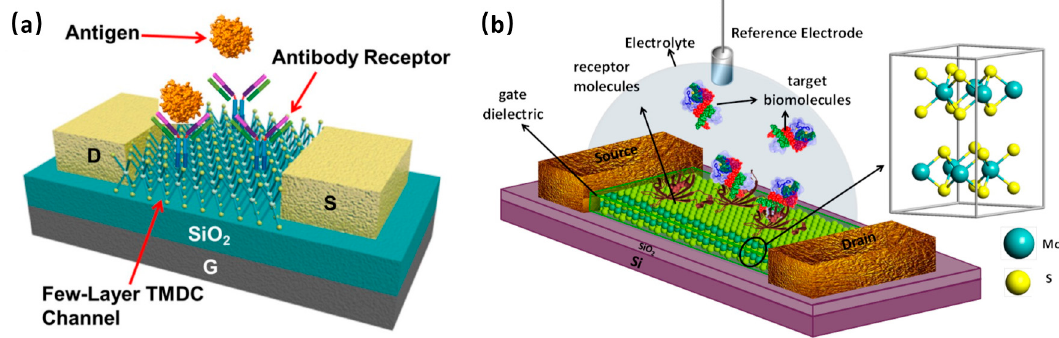
Figure 1. ( a ) Schematic illustration of the back-gated field-effect transistors (FET) biosensor with a few-layer transition metal dichalcogenide (TMDC) sensing channel [33]. Reprinted with permission from ref [33]. Copyright 2015 American Vacuum Society. ( b ) Schematic diagram of liquid-gating MoS 2 -based FET biosensor [34]. Reprinted with permission from ref [34]. Copyright 2014 American